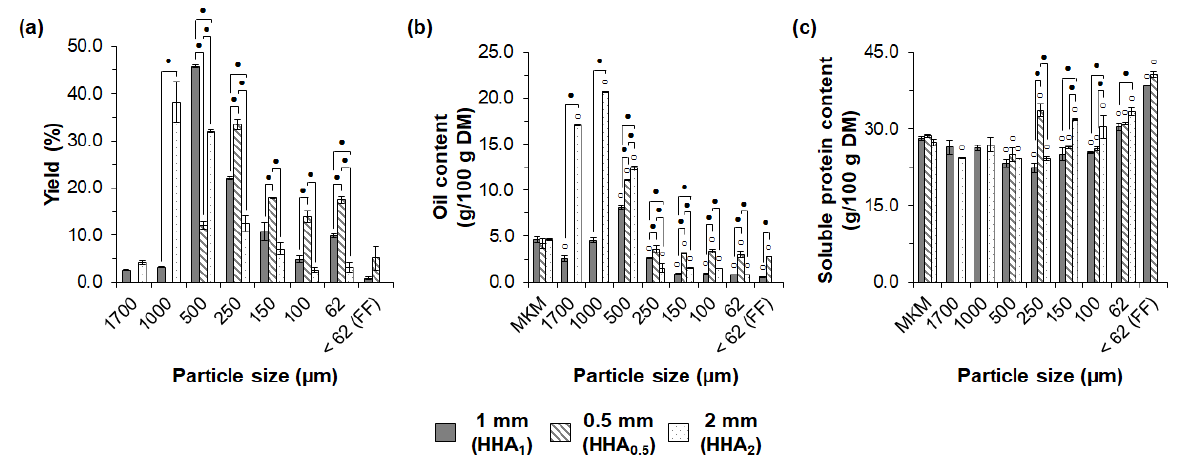
Figure 4. Influence of milling on exploratory sieve fractionation of macauba kernel meals from hydraulic pressing and hexane extraction: ( a ) yields, ( b ) oil content, and ( c ) soluble protein content of the sieved fractions. MKM: macauba kernel meal; FF: fine fraction. White circles indicate significant differences ( p < 0.05) in relation to respective MKMs. Dark circles indicate significant differences ( p < 0.05) between fractions of the same particle sizes and different milling conditions.